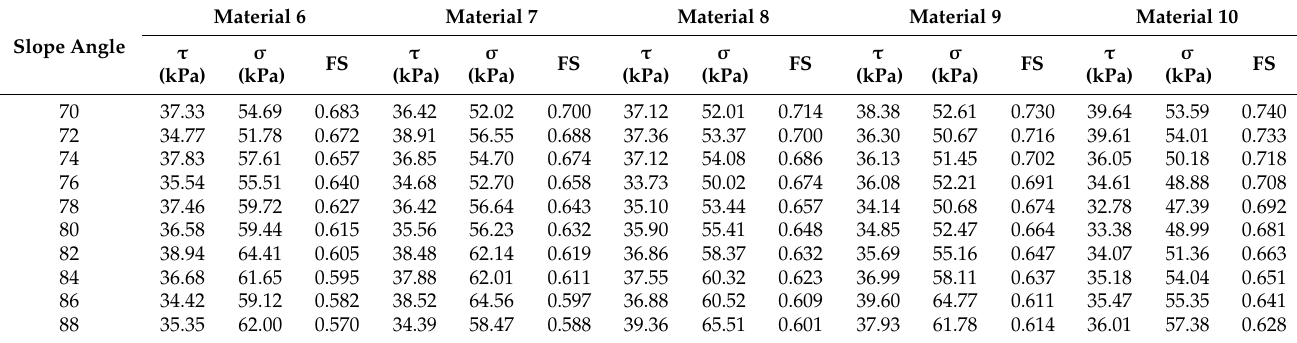
Table 3. τ and σ in the case of a saturated seismic analysis—Materials 6 to 10.